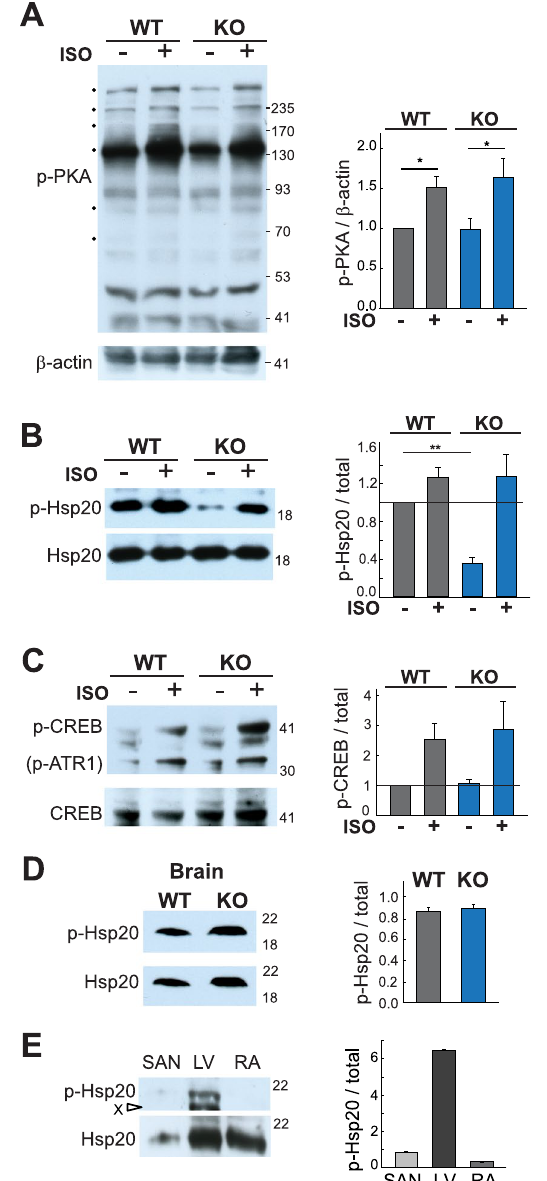
Figure 3. Decreased PKA phosphorylation of Hsp20 in AC9 − / − . WT and AC9 − / − mice were injected with saline or isoproterenol (2 µ g/g body weight, IP). Animals were sacrificed 4 min later and heart tissue was harvested. Cardiac extracts were prepared in the presence of phosphatase inhibitors. Equal protein supernatants were subjected to WB analysis with ( A ) anti-p-PKA substrate, ( B ) anti-p-Hsp20, and C) anti-p-CREB. Quantitation of phospho-PKA was normalized to beta-actin levels (A) while the corresponding total protein was quantitated by WB (n = 5–7) and the ratio of phosphoprotein to total was quantitated for p-Hsp20 (B) and p-CREB ( C ). ( D , E ) WB and quantitation of the ratio of phosphorylated to total Hsp20 in D ) brain from WT and AC9 − / − mice (n = 3) and ( E ) sinoatrial node, left ventricle, and right atrium (n = 3). Graphs for quantitation of the ratio of phosphorylated to non-phosphorylated protein are shown to the right for each panel. ** P < 0.01 t-test on raw intensity values. Full-length WBs are presented in Supplementary Fig.